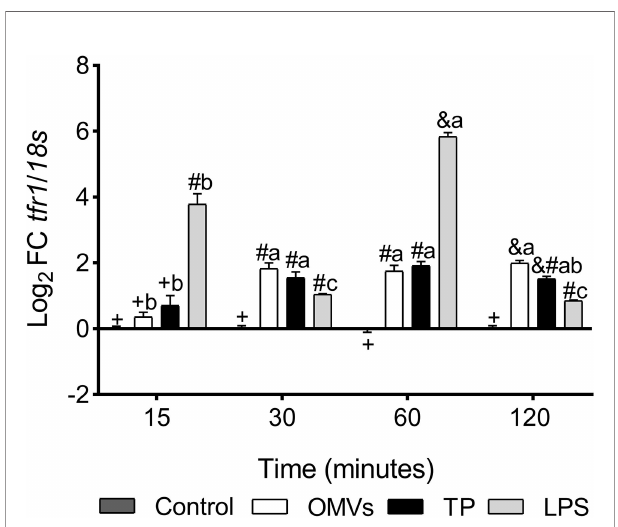
FIGURE 2 | Transcription of tfr1 in SHK-1 cell line stimulated with 1 m g each PAMPs of P. salmonis at 15-, 30-, 60- and 120-minutes post-stimulation. Expression analysis of mRNA was performed by qPCR and 18s was used for normalization. Symbols over the bars indicate statistical differences between the different treatments at the same time points. Different letters indicate statistical differences in the same treatment at different times. Two-way ANOVA, p < 0.05; n=3.